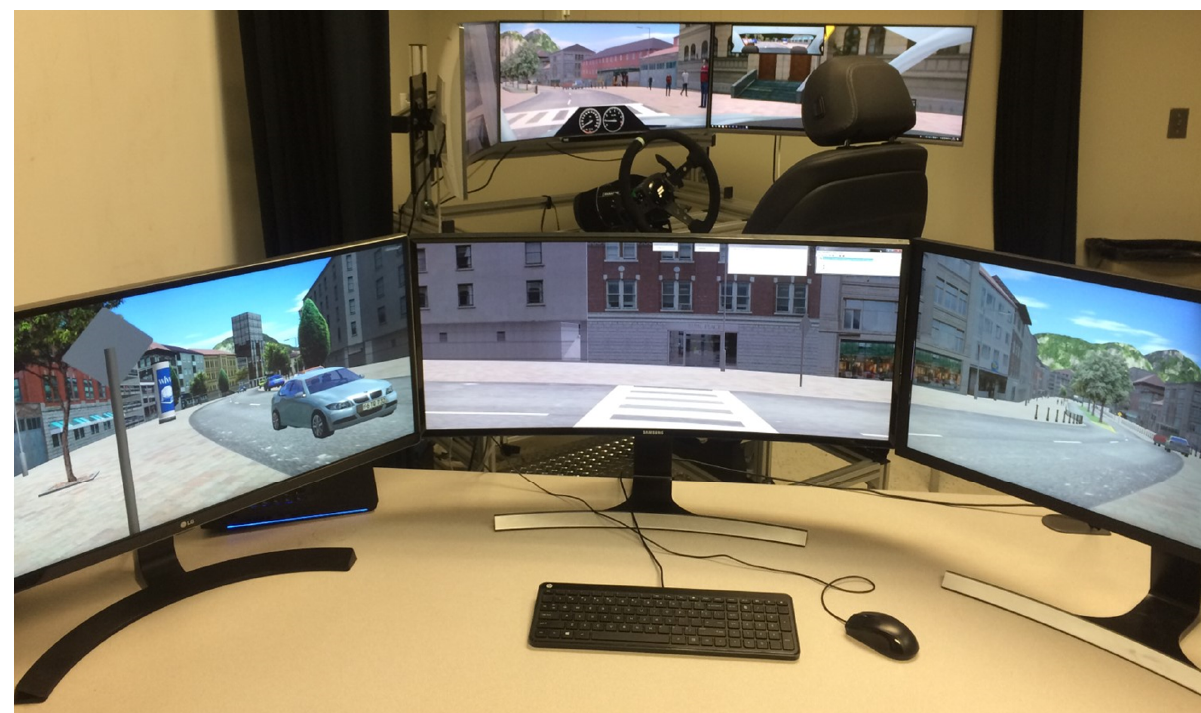
Figure 1. Driving simulator (background) and pedestrian simulator (foreground).The driving simulator (background) shows the driver’s point of view with rear view mirror, side view mirrors, and a simple speedometer and Revolutions Per Minute (RPM) indication as well as a pedestrian target on the right of the center screen. The pedestrian simulator (foreground) shows the crossing from the perspective of the human-controlled pedestrian (HCped) from the assistant’s point of view. The HCped is waiting to cross the road with the participant’s vehicle approaching from the left. Black curtains (here, shown open) were closed around the driving simulator to ensure that the assistant could not see the driving simulator.